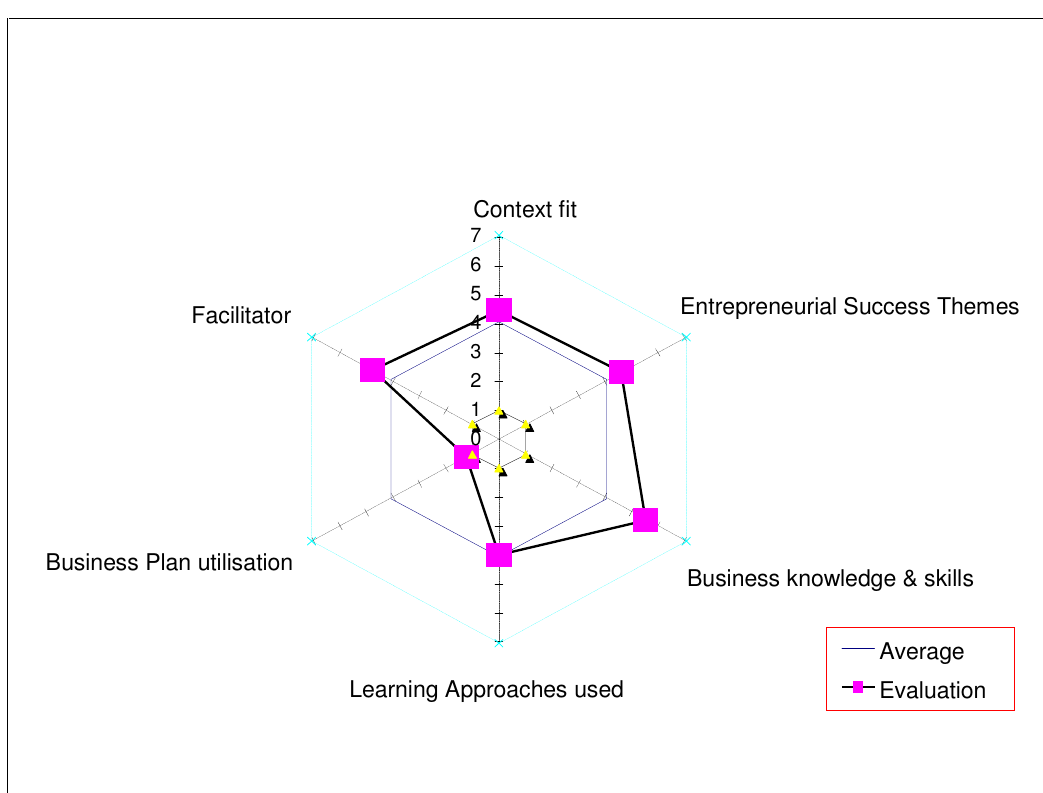
Figure 1: Assessment results for the programme